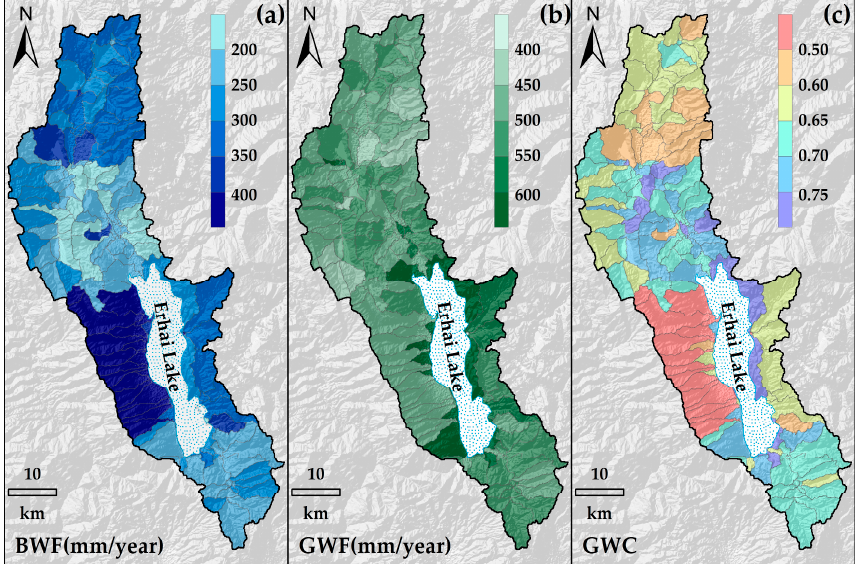
Figure 10. The spatial distribution of annual average BWF ( a ) GWF ( b ), and GWC ( c ) (2009 to 2016).